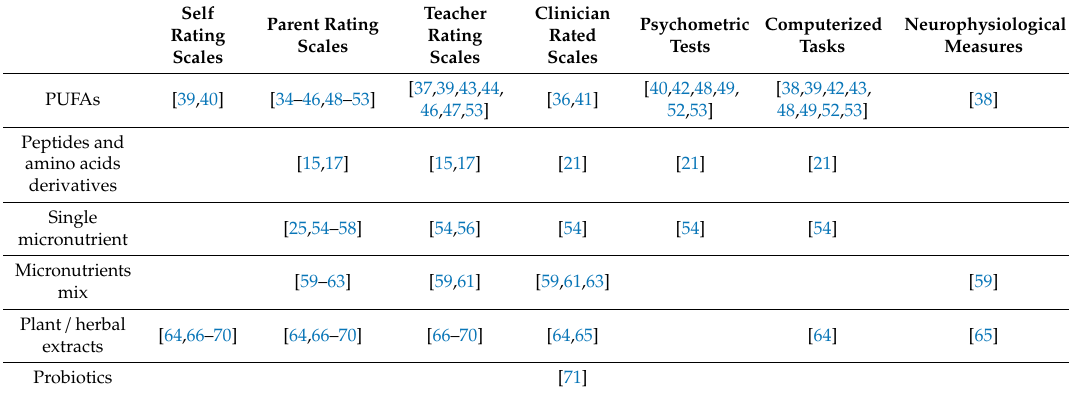
Table 2. Summary of sources of information that were considered in the reviewed